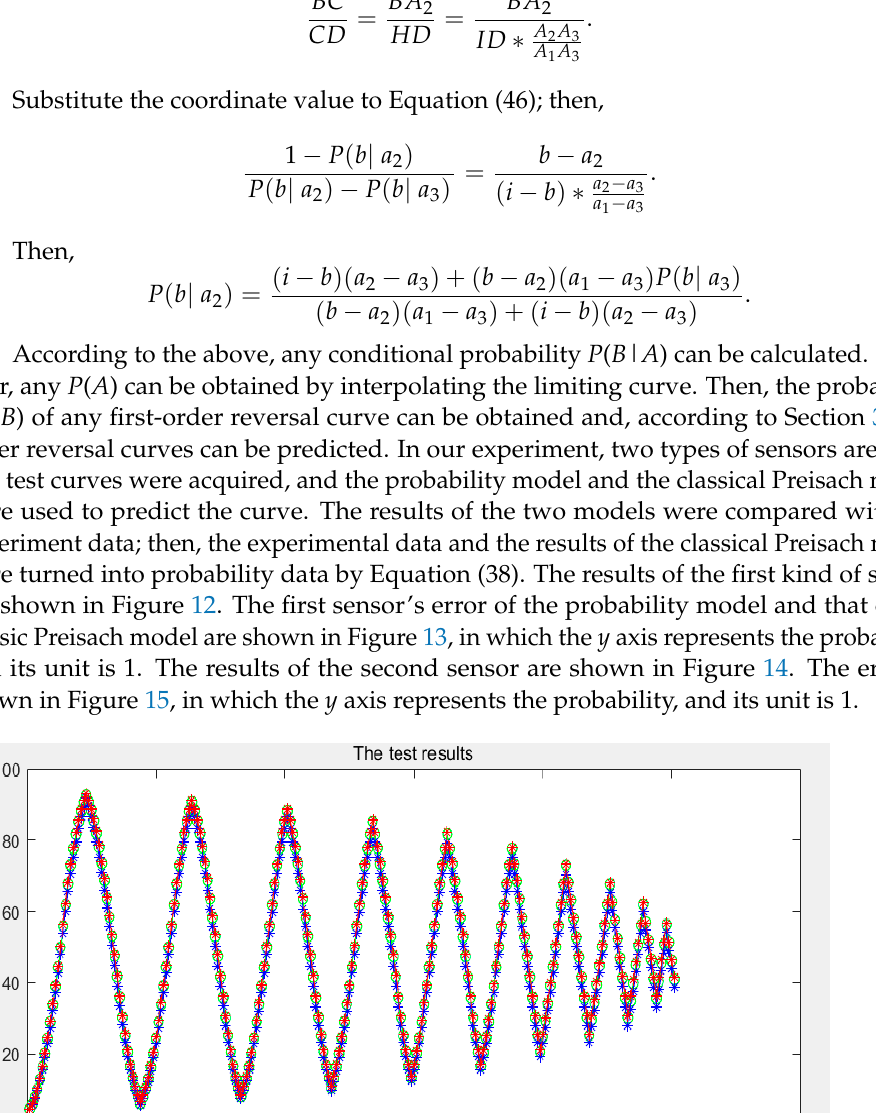
Figure 13. Errors of the first kind sensor.